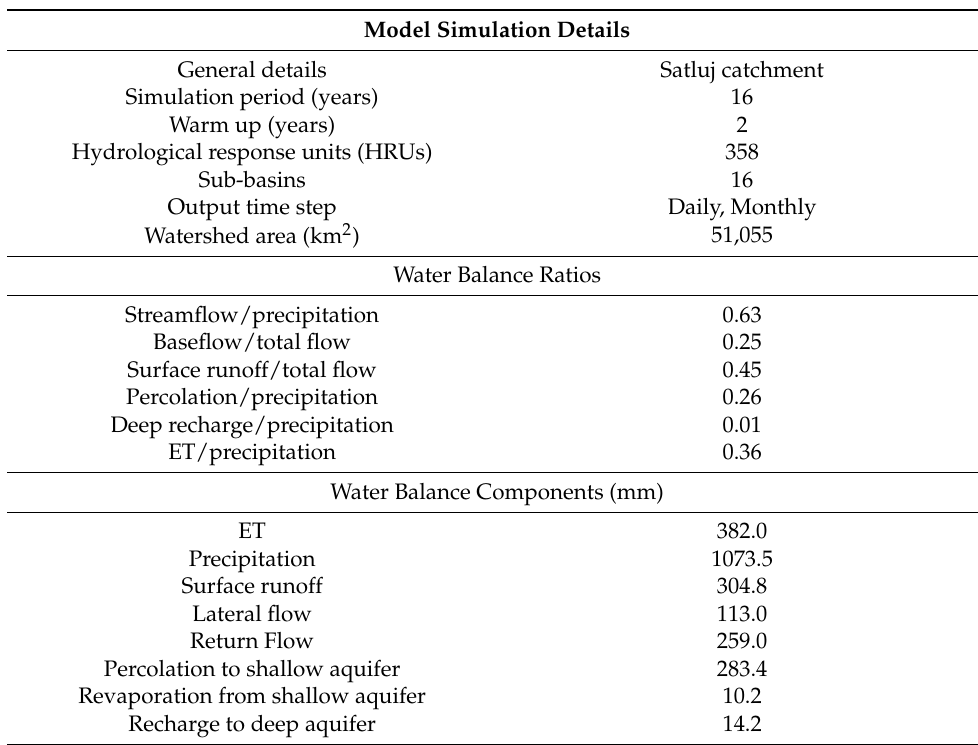
Table 1. SWAT model simulated water balance components